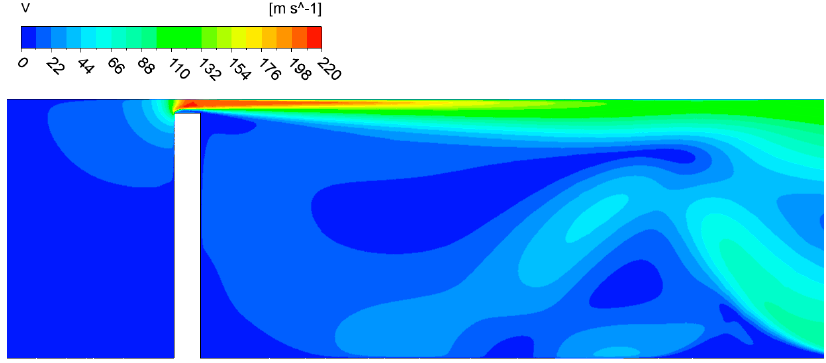
Figure 8. Distribution of the gas velocity in the axisymmetric clearance.